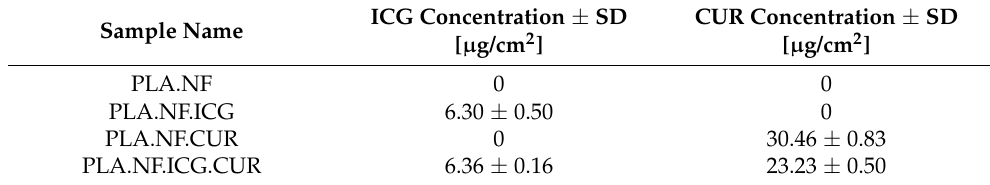
Table 2. ICG and CUR concentration of the prepared nanofibers with their mean fiber diameter.